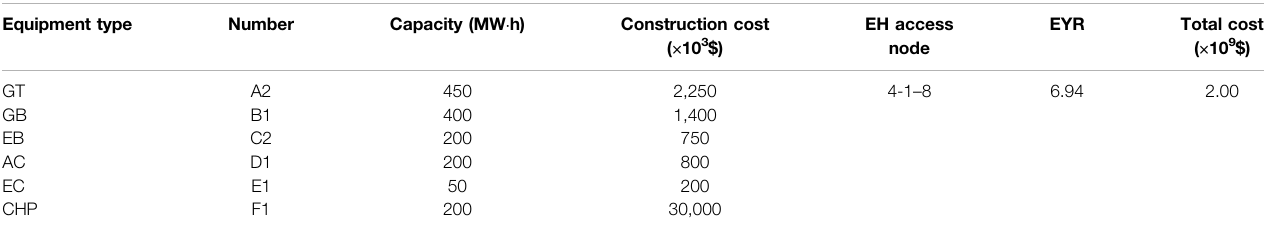
TABLE 4 | EH planning results under S3. Equipment type